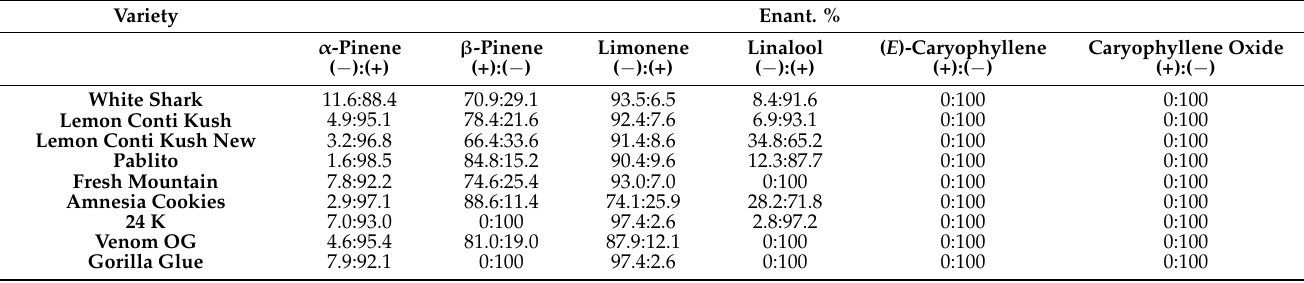
Table 3. Chiral GC-MS analysis results for the 9 commercial varieties